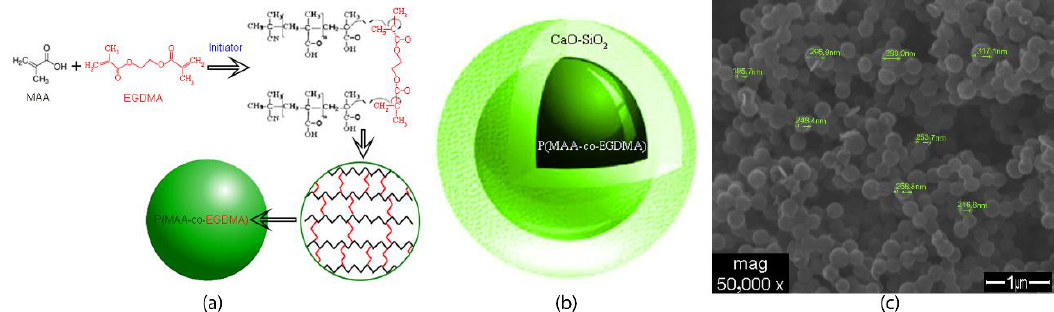
Figure 1. Polymerization reaction to form the organic core P(MAA-co-EGDMA ( a ), schematic representation of organic core—inorganic shell ( b ), SEM image of the synthesized SAPs/P(MAA-co-EGDMA)@CaO-SiO 2 ( c ), revealing the homogenous spherical morphology of SAPs particles in the nanoscale.